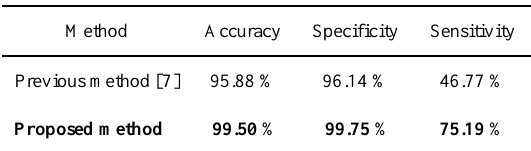
Fig. 4. Image (a) is the green channel before gaussian filter, and (b) is after gaussian filter